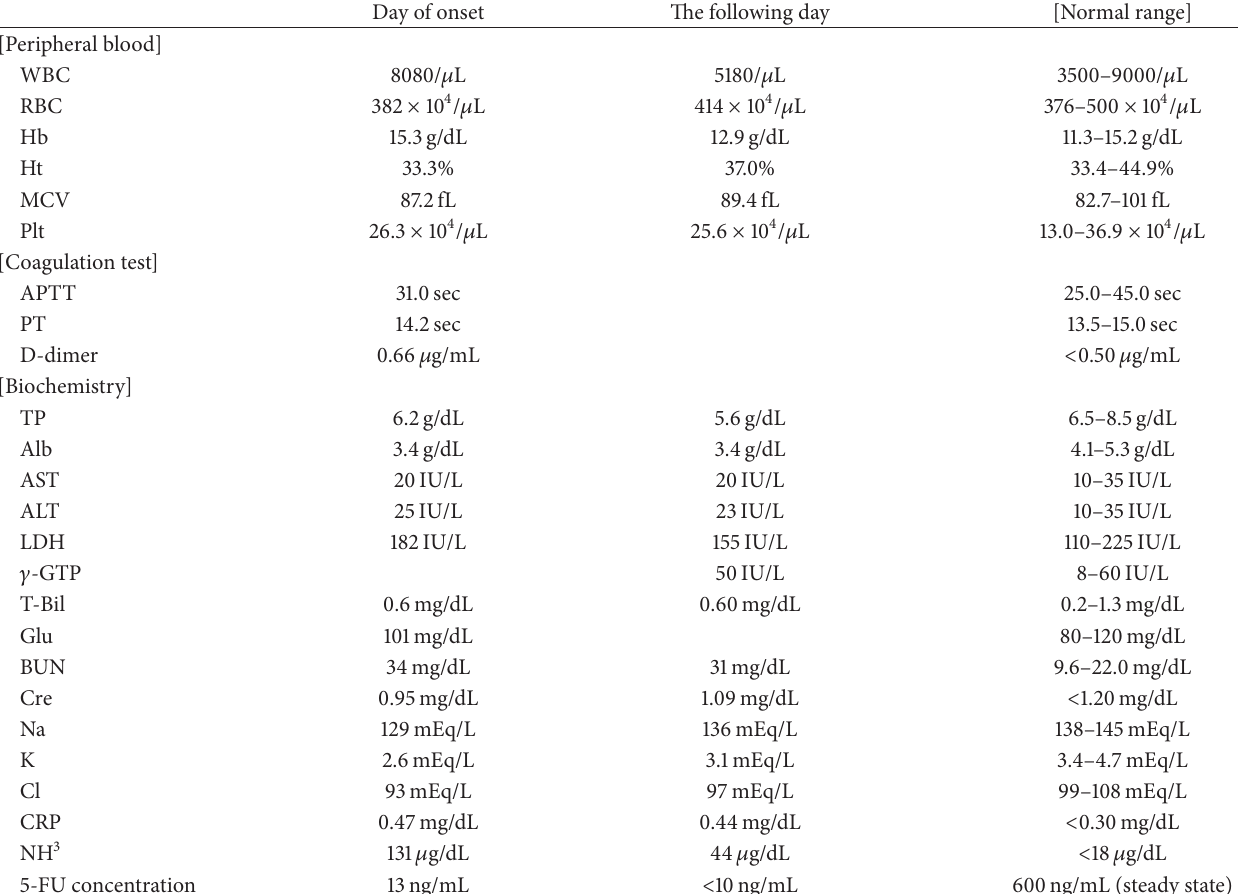
Table 1: Laboratory findings.